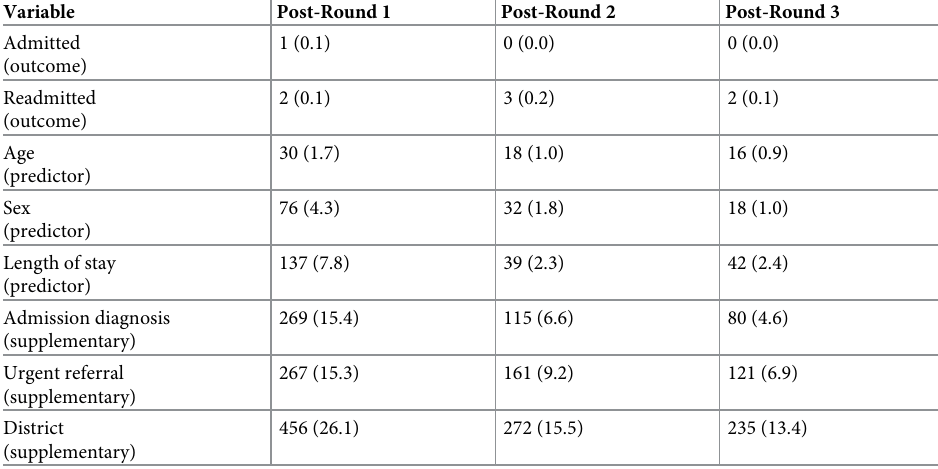
Table 7. Records per variable suppressed to meet 15-anonymity requirement after each round of generalization, N